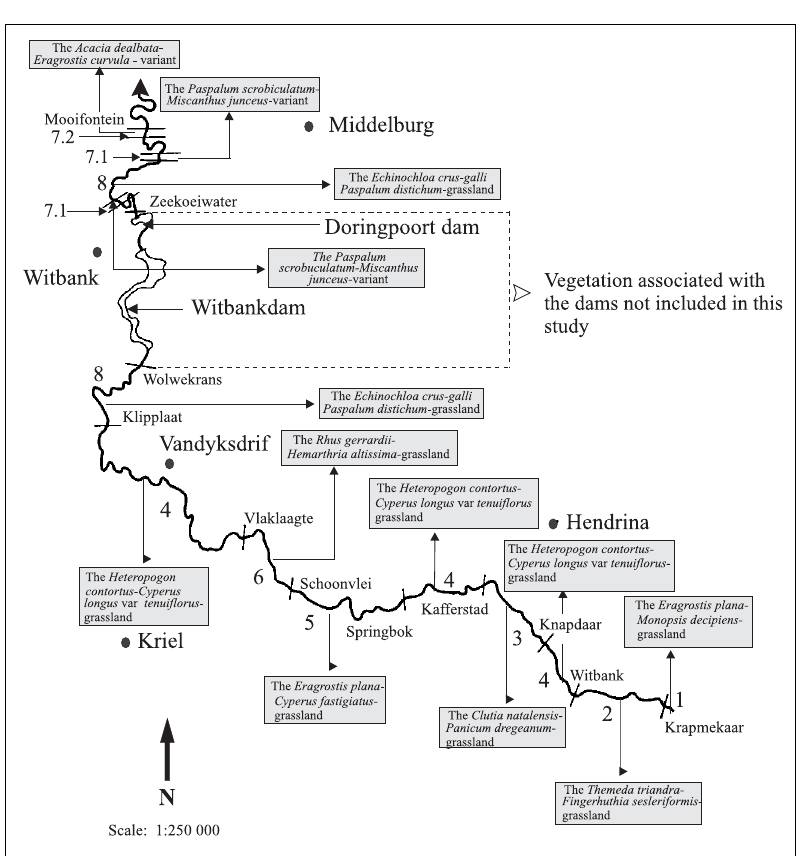
Fig. 1. Distribution of the plant communities of the Olifants River associated with the Grassland